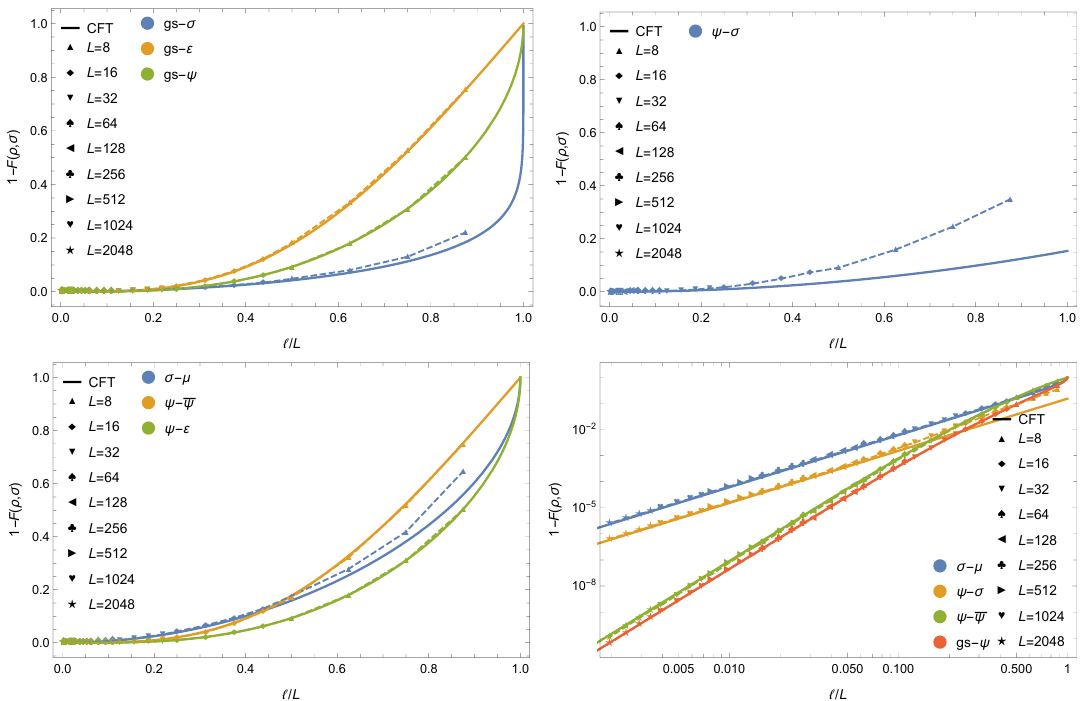
Figure 10 . Fidelity F ( (cid:27); (cid:26) ) as a function of the ratio between the subsystem ‘ and the system size L in the free fermion theory. Solid lines are the CFT predictions, eqs. (5.19) to (5.23). The symbols joined by dashed lines represent numerical data, with di(cid:11)erent symbols corresponding to di(cid:11)erent L . Di(cid:11)erent colours correspond to di(cid:11)erent pairs of states (cid:26) and (cid:27) . matches with the analytical CFT results. We further check various analytical subsystem relative entropies and (cid:12)delities in the boson and fermion theories with the numerical spin chains